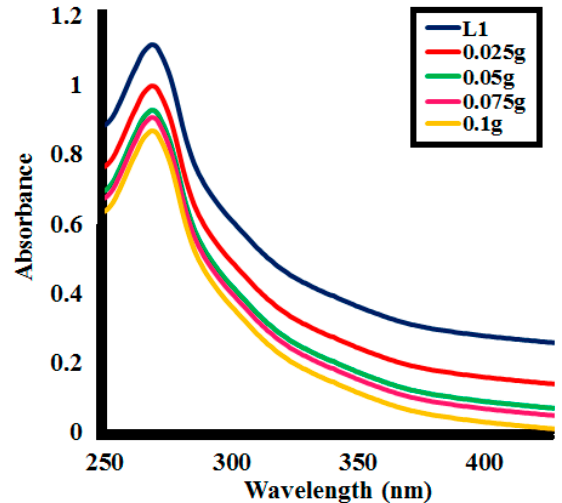
Figure 9. Photocatalytic lignin ( L1 100ppm ) depolymerization by different catalyst doses of SK9 after 60 min of catalytic activity. Table 3. %Lignin ( L1 100ppm ) depolymerization by different catalytic doses of SK9 at different time intervals.